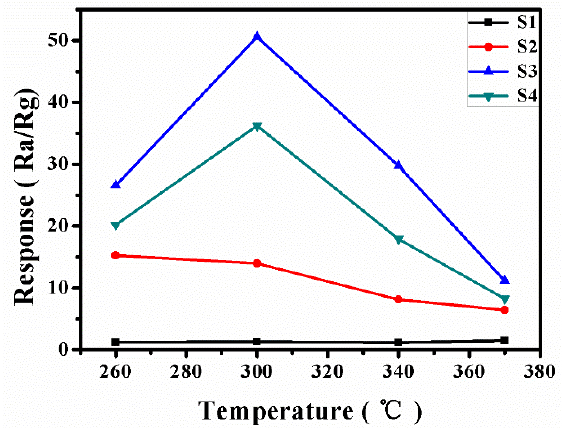
Figure 6. The responses of the samples (S1–S4) to 100 ppm cyclohexene vapor at different temperatures.